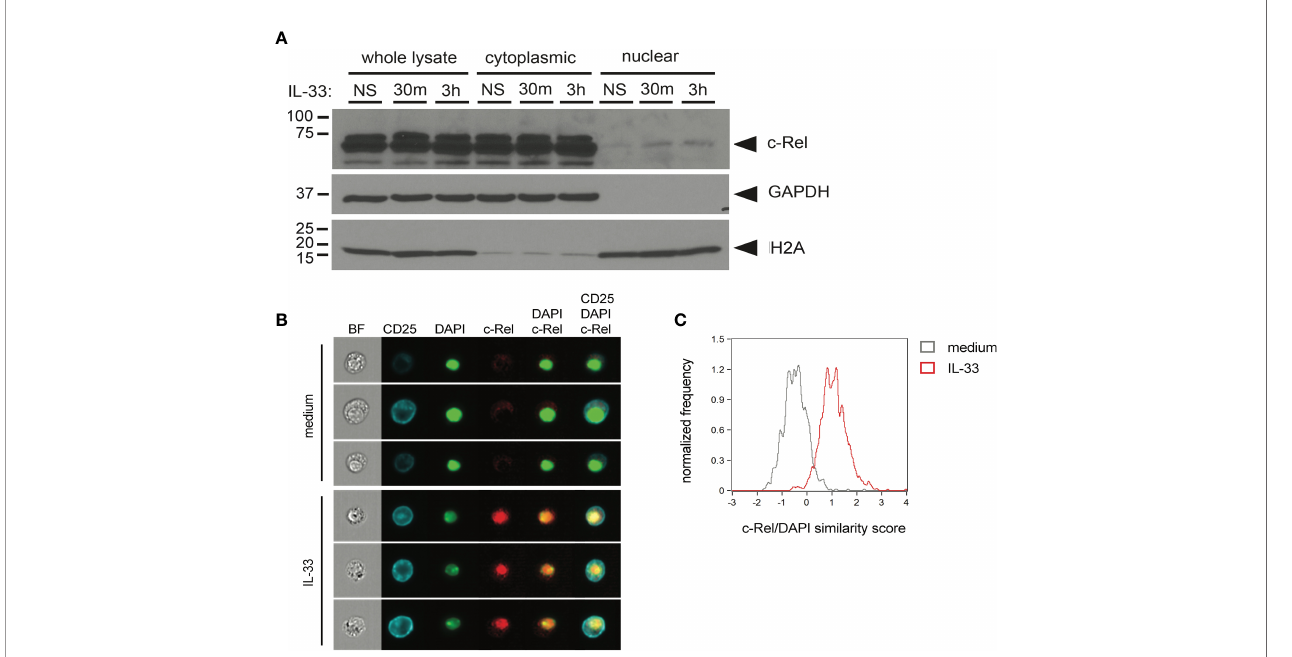
FIGURE 4 | c-Rel translocates to the nucleus upon ex vivo activation of group 2 innate lymphoid cells (ILC2s) by IL-33. (A) Ex vivo expanded bone-marrow derived ILC2s were left unstimulated (NS) or cultured with IL-33 (100 ng/ml) for 30 min or 3 h. Whole-cell, cytoplasmic, and nuclear lysates were probed for c-Rel by Western blotting. Expression of GAPDH and H2A served as fractionation and loading controls. (B, C) ImageStream analysis of isolated lung ILC2s left unstimulated (medium) or cultured with IL-33 (10 ng/ml) for 3 h. (B) Representative images (from left to right) of bright- fi eld (BF), CD25, DAPI, and c-Rel as well as merged images of DAPI + c-Rel and CD25 + DAPI + c-Rel. (C) Quanti fi cation of nuclear translocation of c-Rel by overlay of c-Rel/DAPI similarity scores of untreated (gray histogram) and IL-33-activated ILC2s (red histogram). Data are representative of at least two independent experiments.